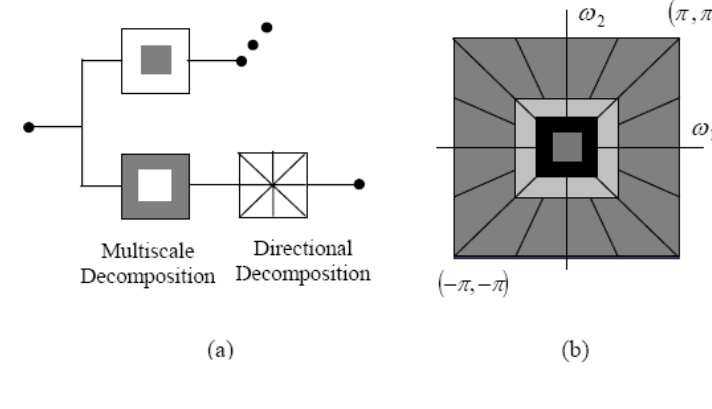
Figure 1. The nonsubsampled contourlet transform: (a) Block diagram. (b) Resulting frequency division, where the number of directions is increased with